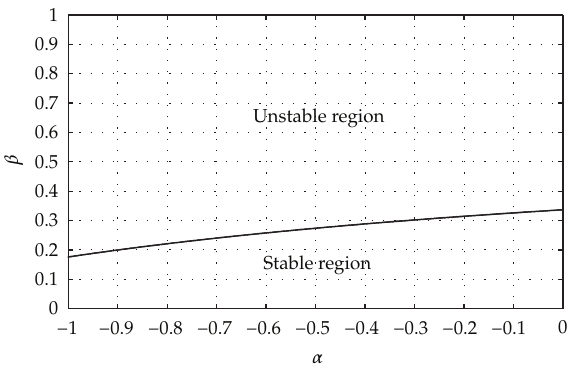
Figure 2: The stable region of the fixed point p 7